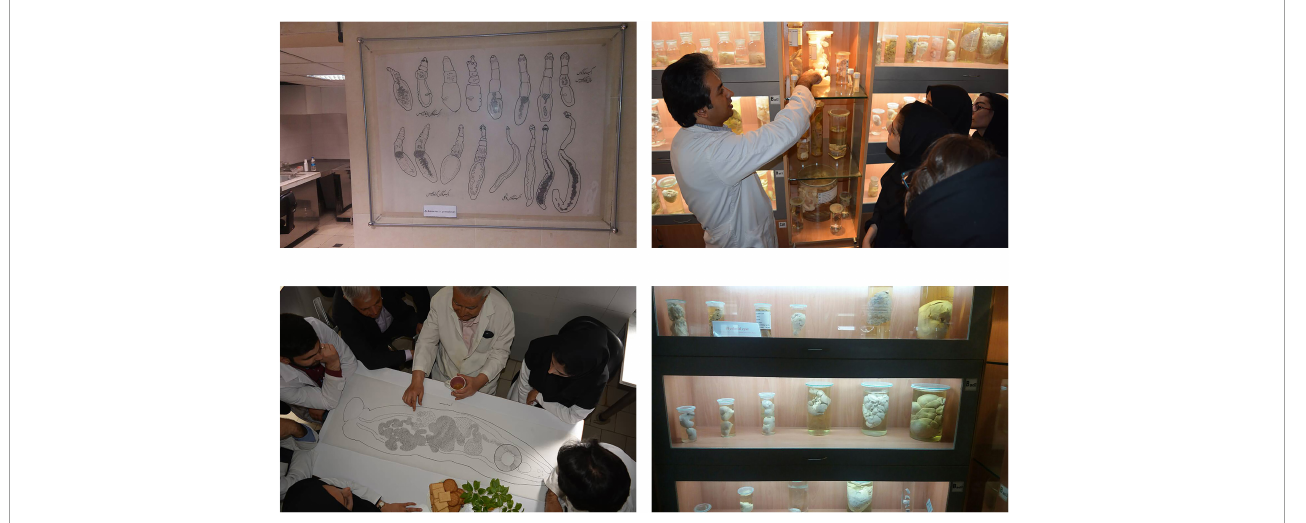
FIGURE3 The role of the Iranian Parasitology Museum in science communication for the public and students. The figures were prepared from the archives of the Iranian Parasitology Museum.